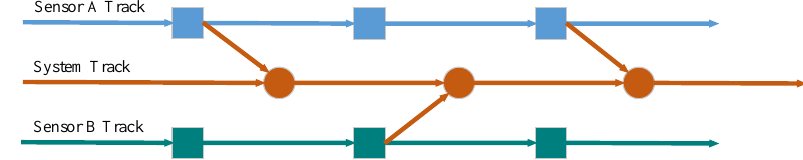
Figure 1. Distributed fusion structure of multiple sensors.